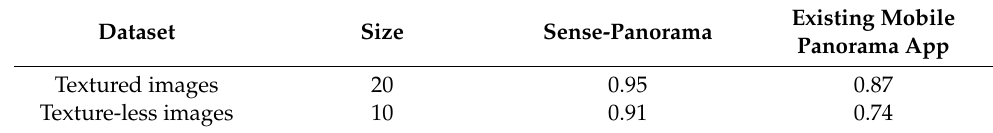
Table 5. Subjective quality evaluation on captured data using a quality